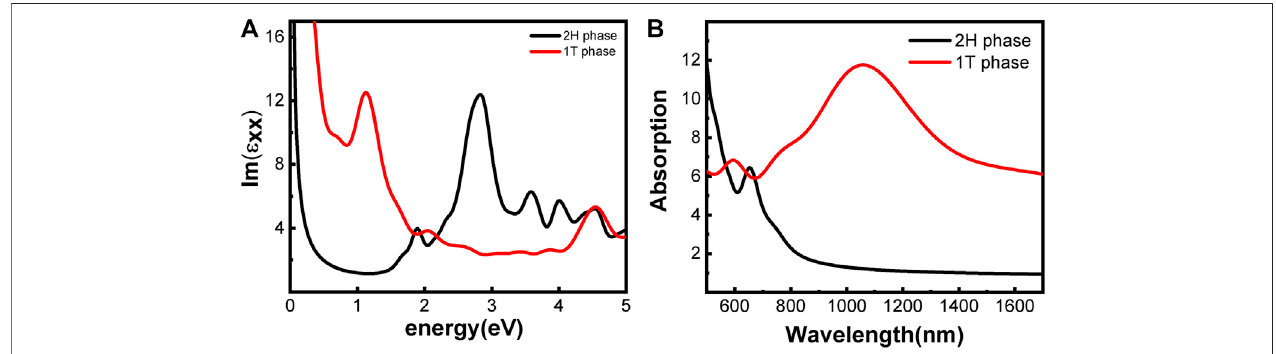
FIGURE 3 | Optical properties of monolayer MoS 2 without defect and doping: (A) imaginary part of the dielectric function; (B) absorption spectra. The phases are indicated by color.